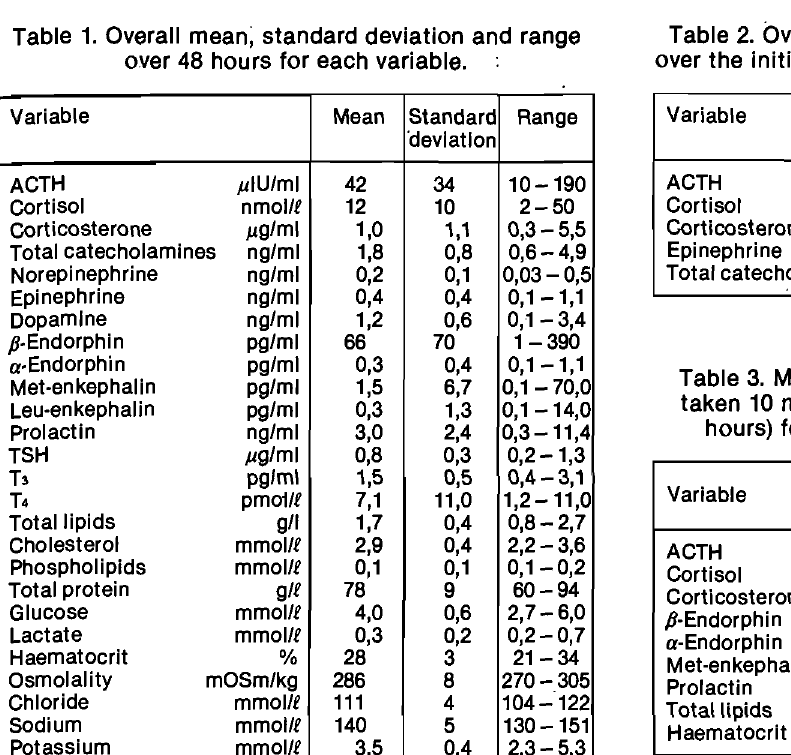
Table 3. Mean and standard deviation for samples taken 10 minutes after stress (after the forty-eigth hours) for variables that changed with